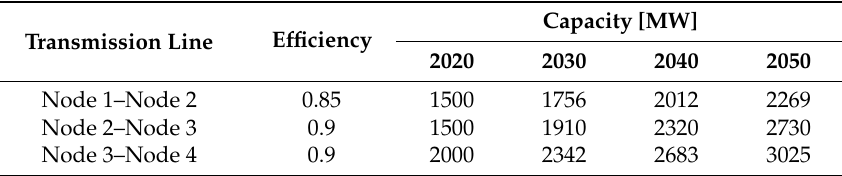
Table 2. Transmission line capacities and efficiencies for Scenarios 0 to